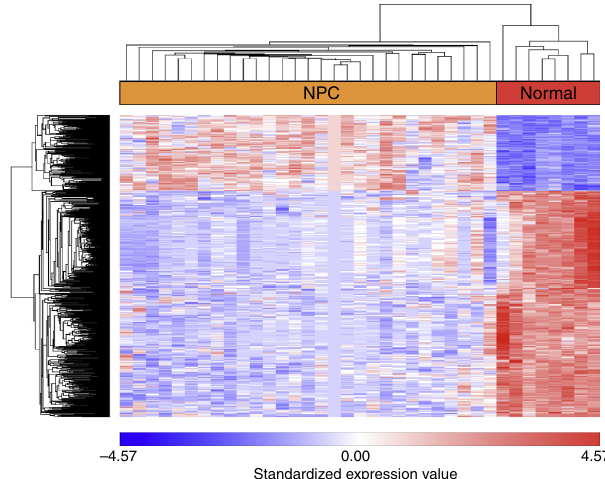
The heat map of the hierarchical cluster analysis for differentially expressed genes (DEGs).